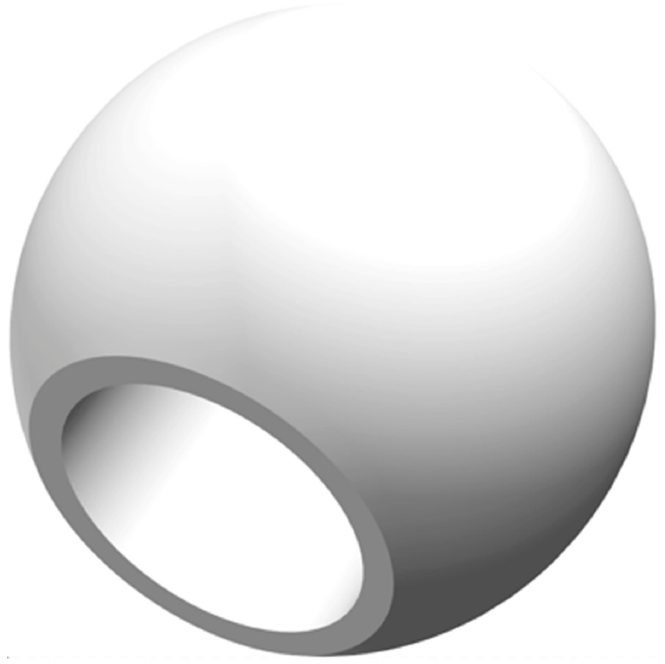
Figure 5. Zirconia femoral head.